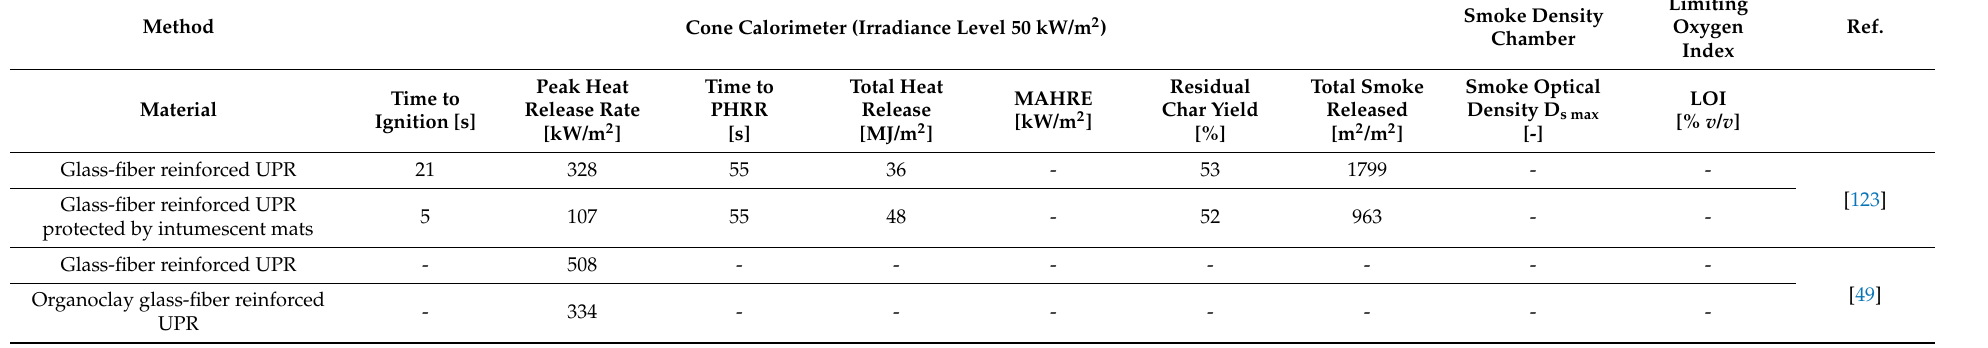
Table 4. A comparison of flammability and smoke properties of flame retardant glass-fiber reinforced composites with UPR matrix and UPR